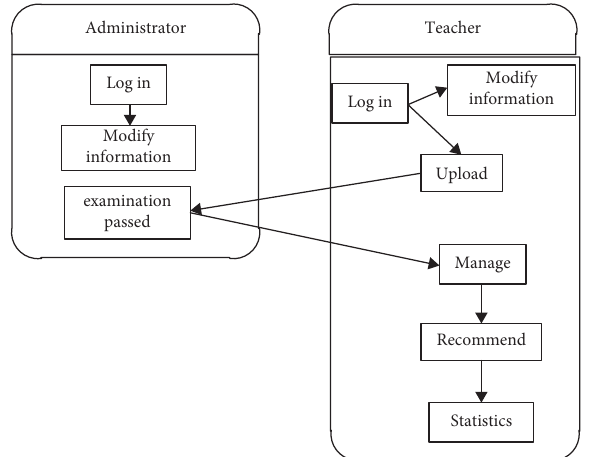
Figure 4: Resource management business flowchart based on the roles of administrators and